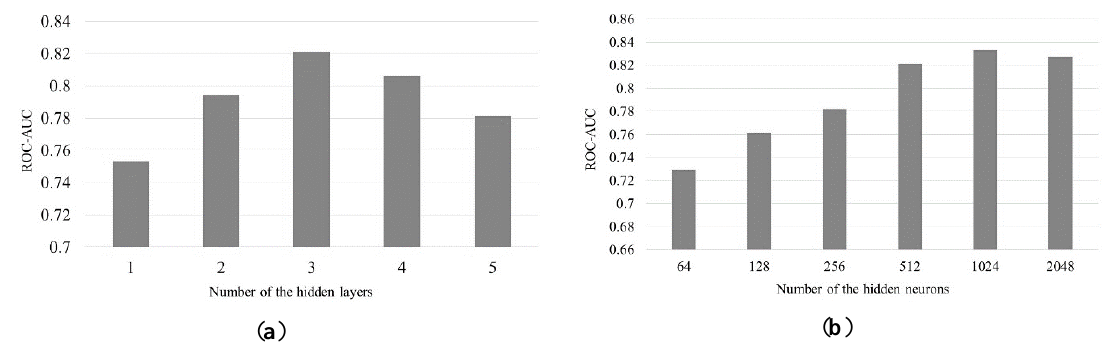
Figure 4. ( a ) ROC-AUC performance among different numbers of hidden layers; ( b ) ROC-AUC performance among different numbers of hidden neurons.